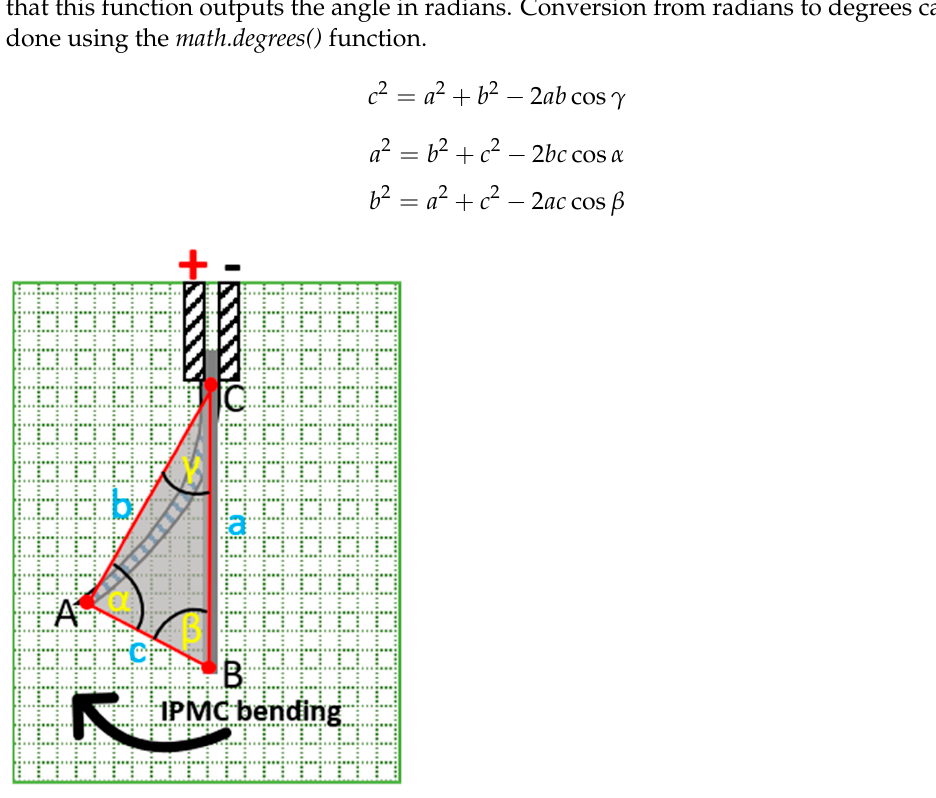
Figure 12. Relating triangle with sides a , b , c and angles α , β , γ to the IPMC setup [29].